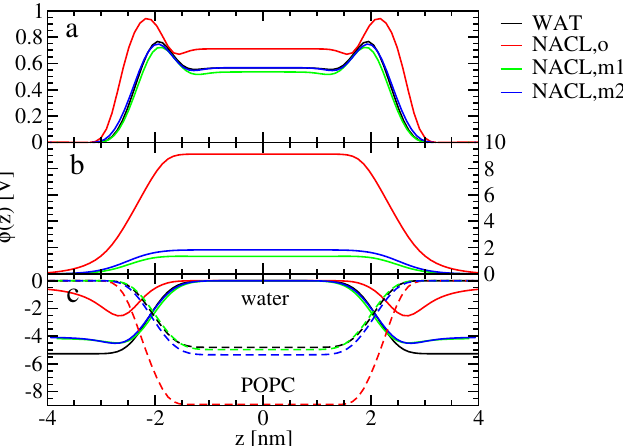
Figure 4. Symmetrized electrostatic potential φ ( z ) along the bilayer normal (Equation (16)), for simulations S wat (wc), S NaCl (o,wc), S NaCl (m1,wc) and S NaCl (m2,wc), shown as black, red, green and blue curves, respectively. The underlying atom-based charge density ρ a ( z ) involves ( a ) all atoms, ( b ) ions or ( c ) only lipid (dashed lines; labeled “POPC”) or water (solid lines; labeled “water”) atoms. The anchoring of the curves was done as described in Section 4.3.1. The simulation acronyms are explained in Table 7. Note that in this illustration, the lipid bilayer is